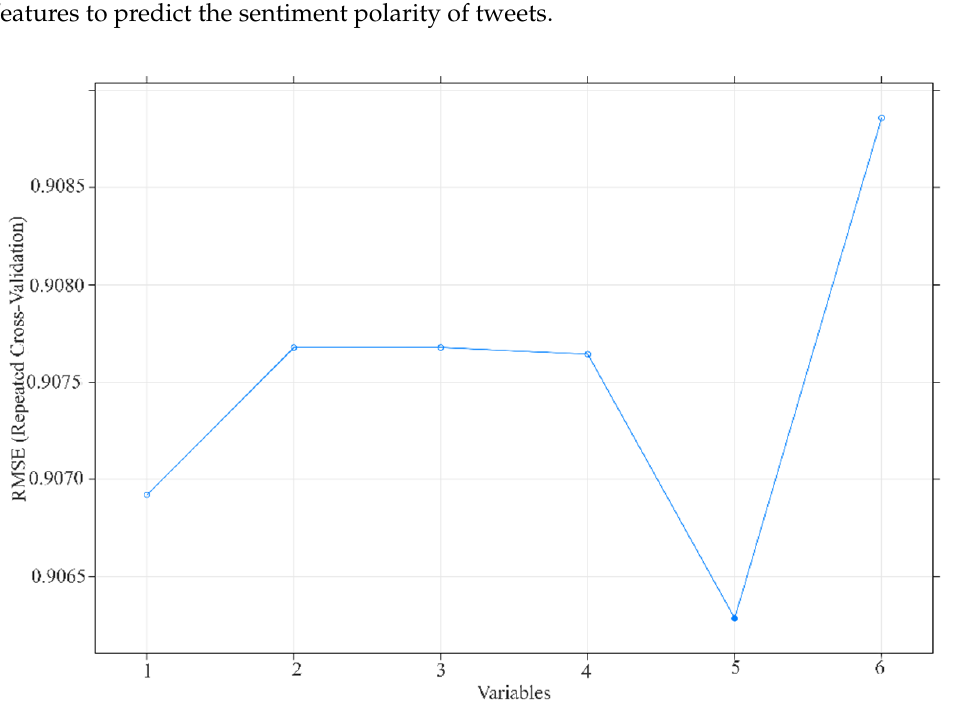
Figure 7. RFE result—ranking of variables based on the model Root Mean Square Error (RMSE). X-axes represent the subset sizes of variables; Y-axes represent the RMSE of the residuals, which indicate the prediction strength of the variables.